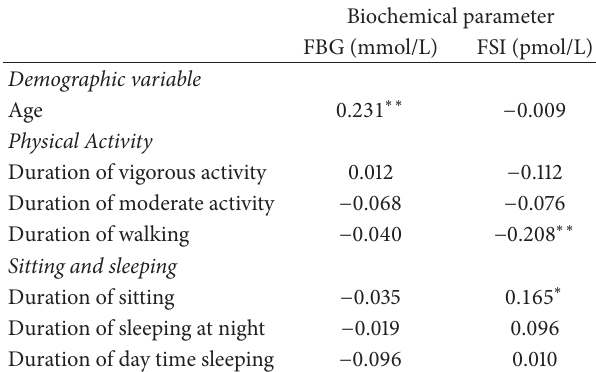
Table 3: Correlation analysis of continuous variables with FBG and FSI.